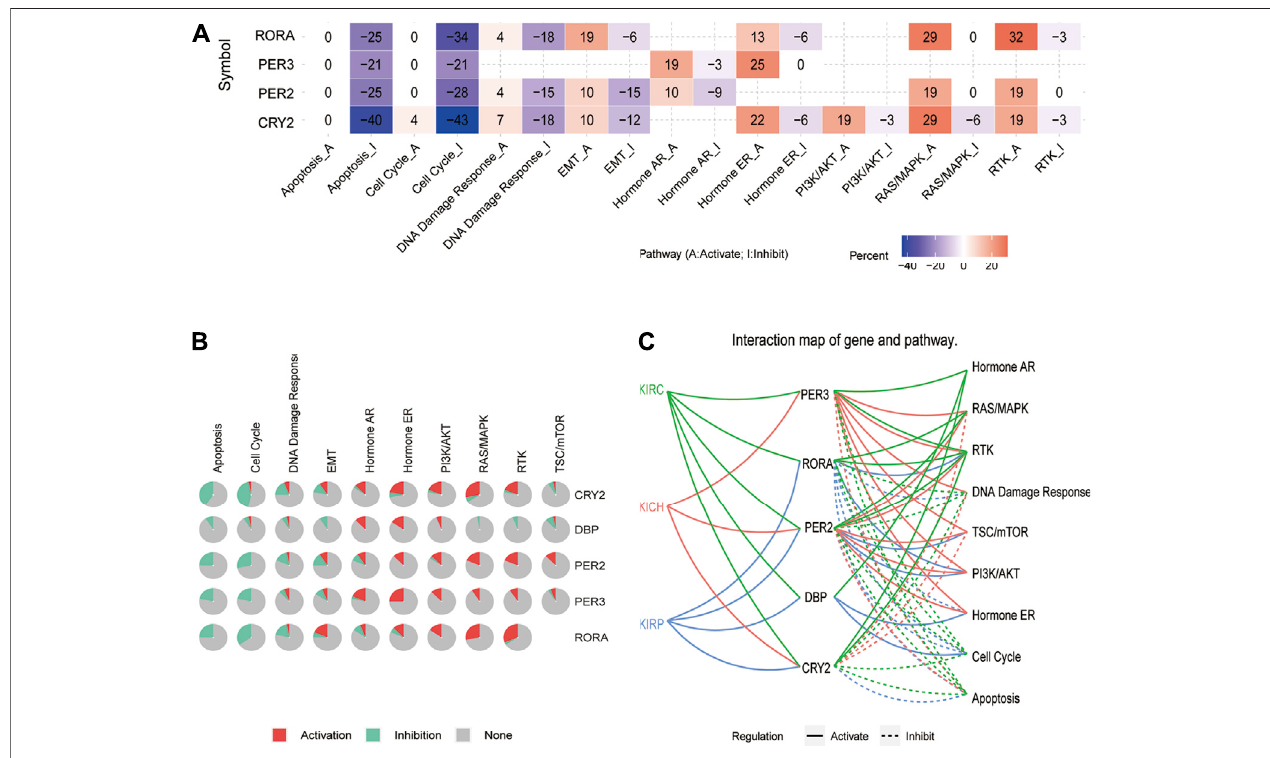
FIGURE 8 | Pathway activity analysis of fi ve prognostic core clock genes in pan-RCC. (A, B) The main role of fi ve prognosis core clock genes in tumor-related marker pathways. Here, columns represent tumor-related marker pathways and rows represent genes, red represents rhythm genes activating immune-related pathways, and blue represents rhythm genes suppressing immune-related pathways. (C) Links between fi ve prognosis core clock genes and hallmark signaling pathways. Solid lines represent rhythmic gene-activated immune-related pathways, and dashed lines represent immune-related pathways of rhythmic